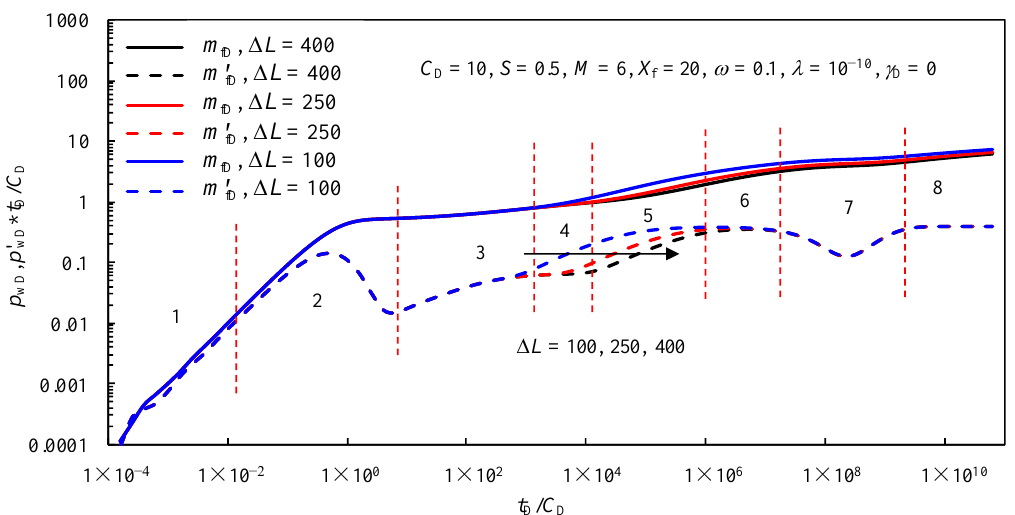
Figure 9. The effect of the spacing of hydraulic fractures on the dimensionless pressure and pressure derivatives of a MFHW in an inter-salt shale oil reservoir.